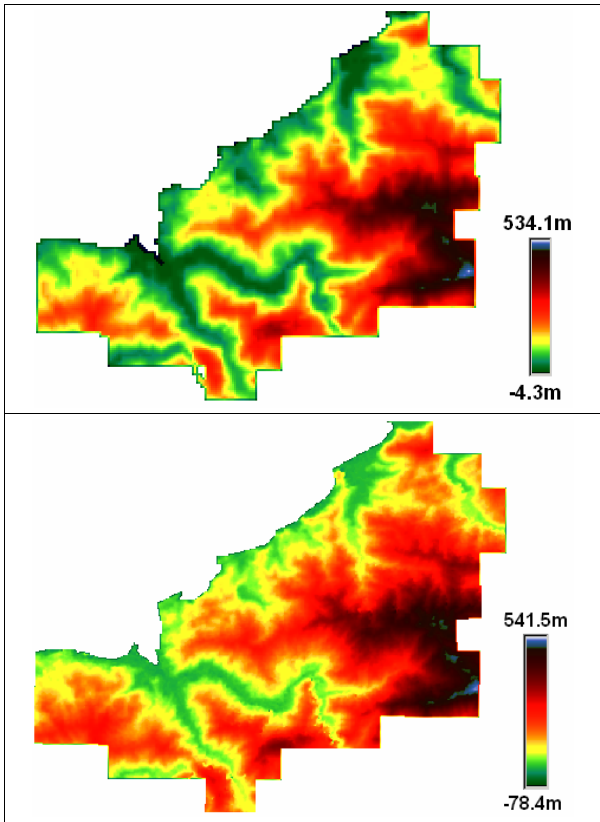
Figure 7. SRTM C- and X-band height model of Zonguldak